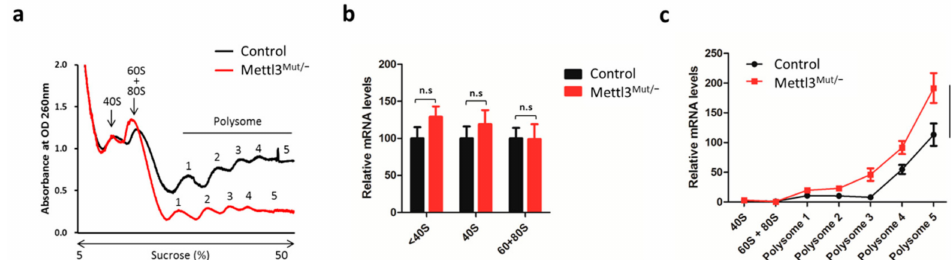
Figure 3. m 6 A modulates translation elongation of TGFB1 mRNA in HeLa cells. ( a ) Polysome profiles of control and Mettl3 Mut / − HeLa cells. Numbers in polysome fraction represent the samples that were used for qRT-PCR in Figure 3c; ( b ) Expression levels of TGFB1 mRNA in ribosome-unbound ( < 40S), 40S, and 60 + 80S fractions from control and Mettl3 Mut / − HeLa cells; ( c ) Expression levels of TGFB1 mRNA in 40S, 60 + 80S and polysome fractions from control and Mettl3 Mut / − HeLa cells. Data are presented as means ± SD from three independent experiments. Student’s t -test, n.s, no significant; *, p < 0.05 compared with